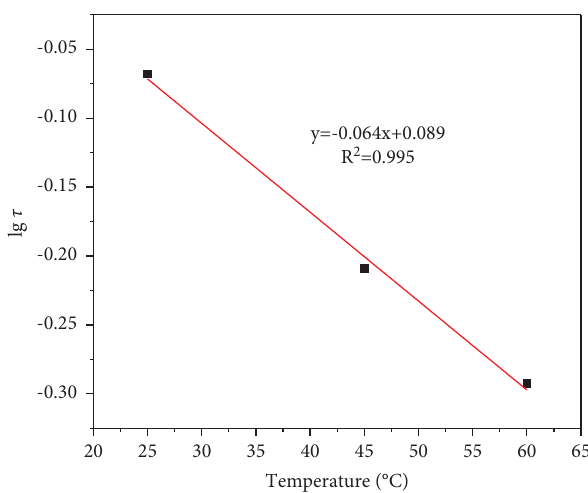
Figure 15: Variation of the logarithm of shear strength with temperature.